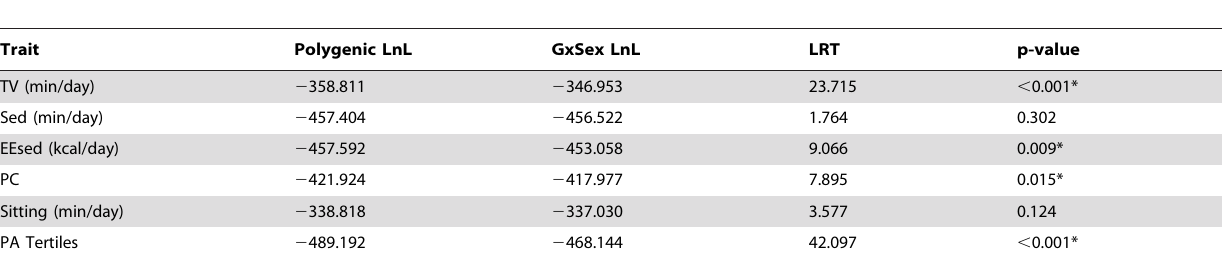
Table 3. Results of log-likelihood ratio tests (LRT) and respective p-values contrasting a polygenic model vs a GxSex model for each of the SB indicators.